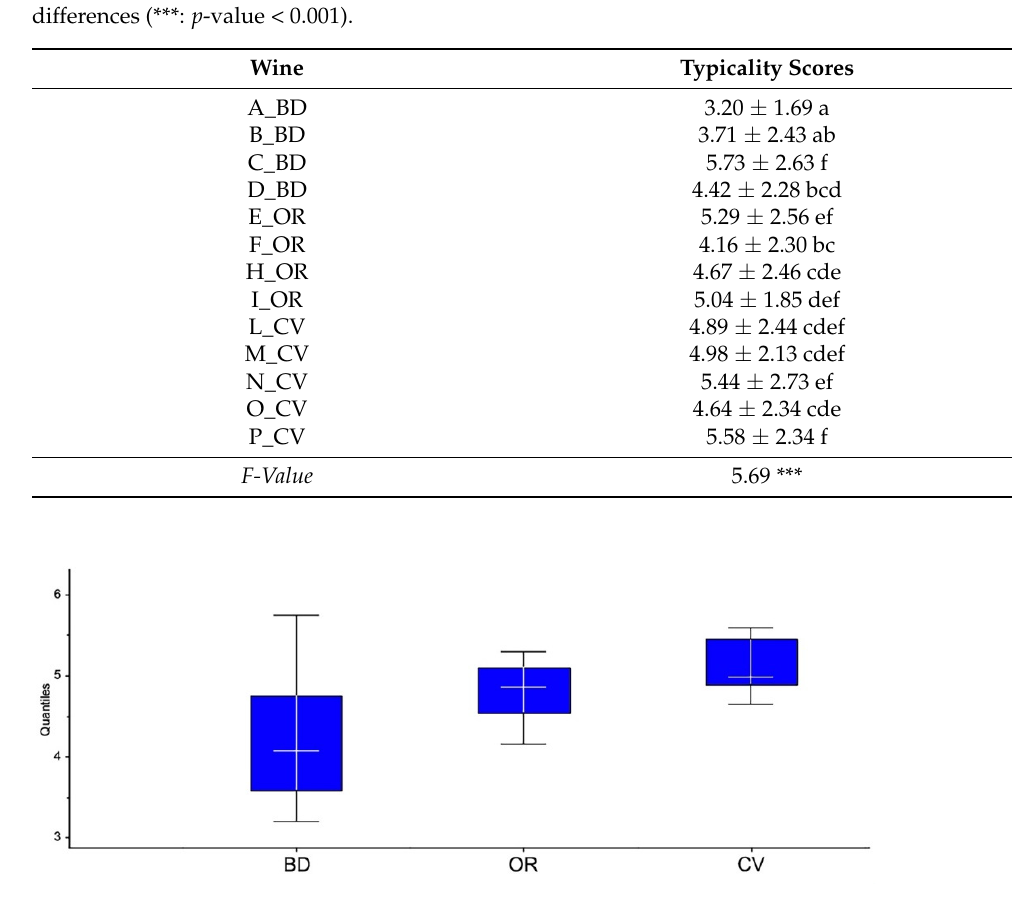
Figure 5. Typicality scores of Chianti DOCG wines from different estate management types (BD biodynamic, OR organic, CV conventional): minimum and maximum, 25% and 75% percentiles, and median. Mean values and standard deviation (with significance p -value < 0.001: BD, 4.27a ± 1.10; OR, 4.79b ± 0.49; CV, 5.11b ± 0.39).